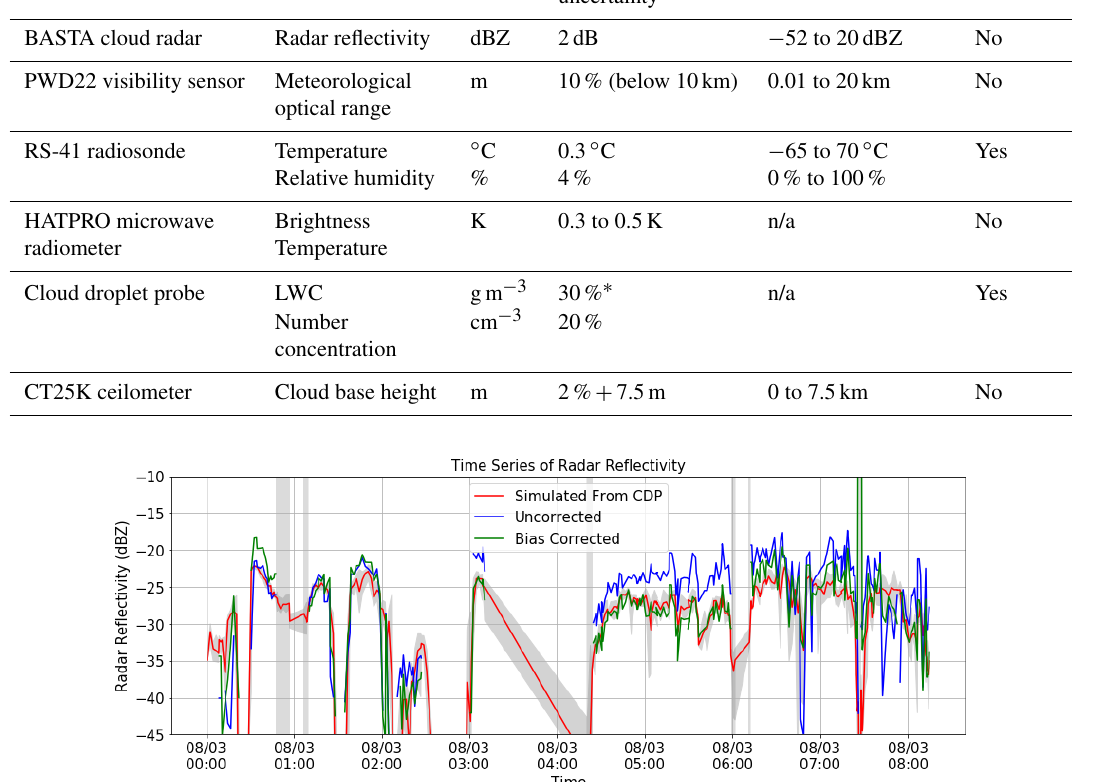
Figure 5. The radar reflectivity simulated from the CDP droplet measurements, observed with the BASTA cloud radar, and the observation after a 1h bias correction had been